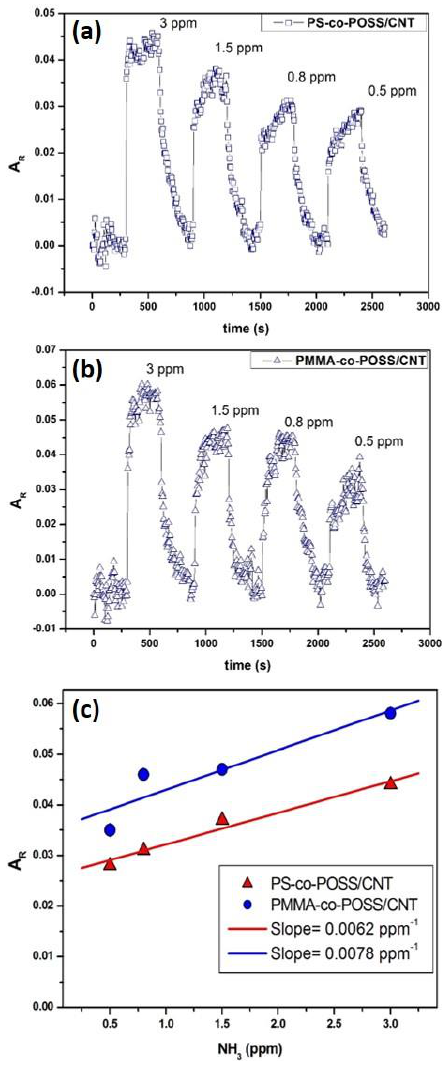
Figure 6. The effect of the addition of 100 ppm on ( a ) PS-co-POSS/CNT and ( b ) PMMA-co-POSS/CNT sensors’ responses when exposed to varying concentrations of NH 3 , and ( c ) their sensitivity determination towards NH 3 .